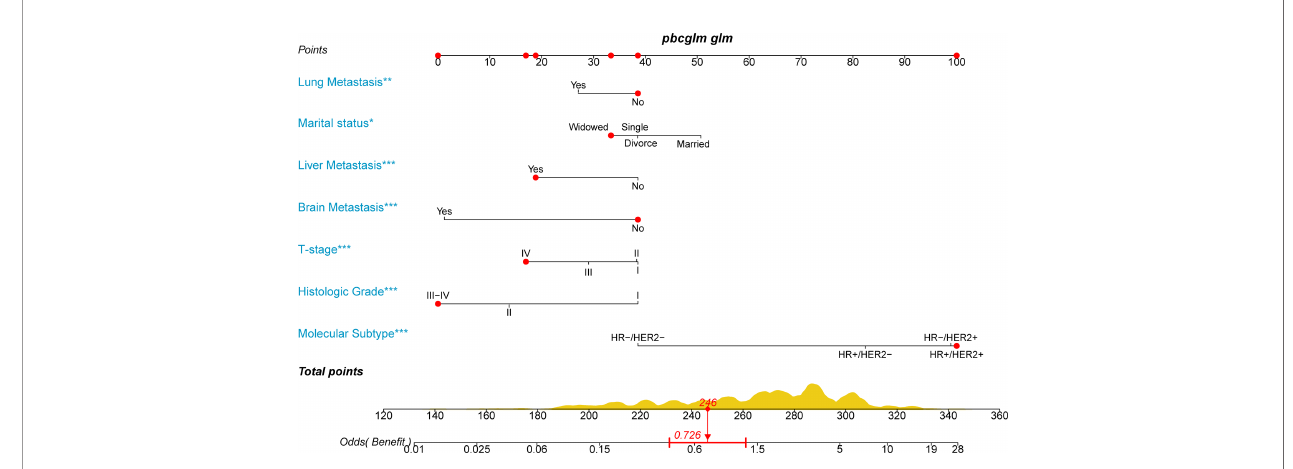
FIGURE 3 | A novel nomogram to select candidates with stage IV BIDC for primary site surgery and predict the possibility of surgical bene fi